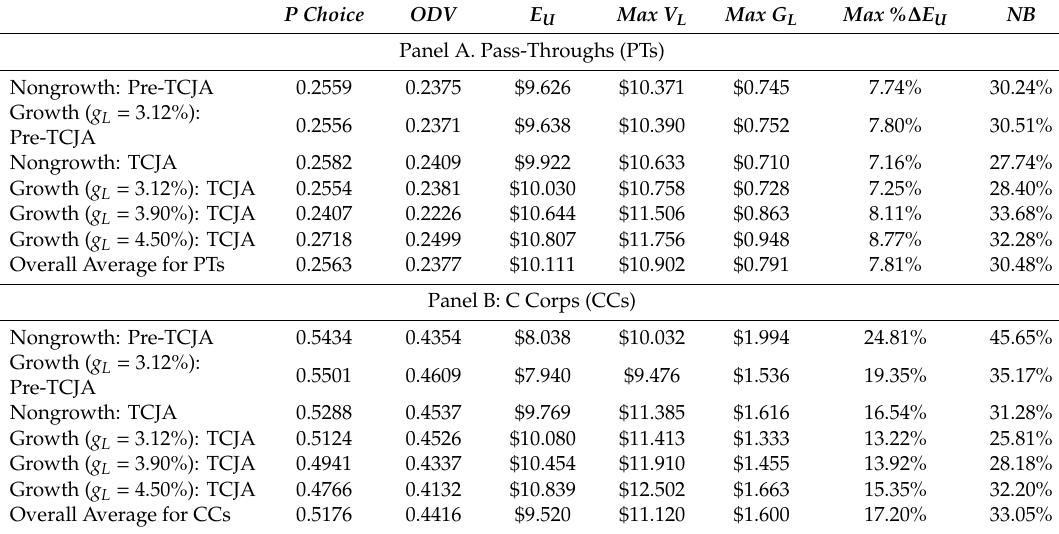
Table 2. Seven Optimal